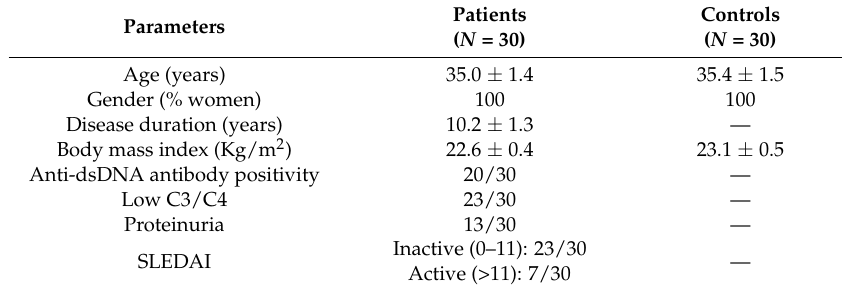
Table 1. Demographic and clinical characteristics of the subjects participated in the study *